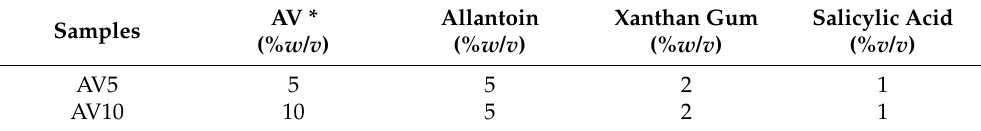
Table 3. Composition of transdermal